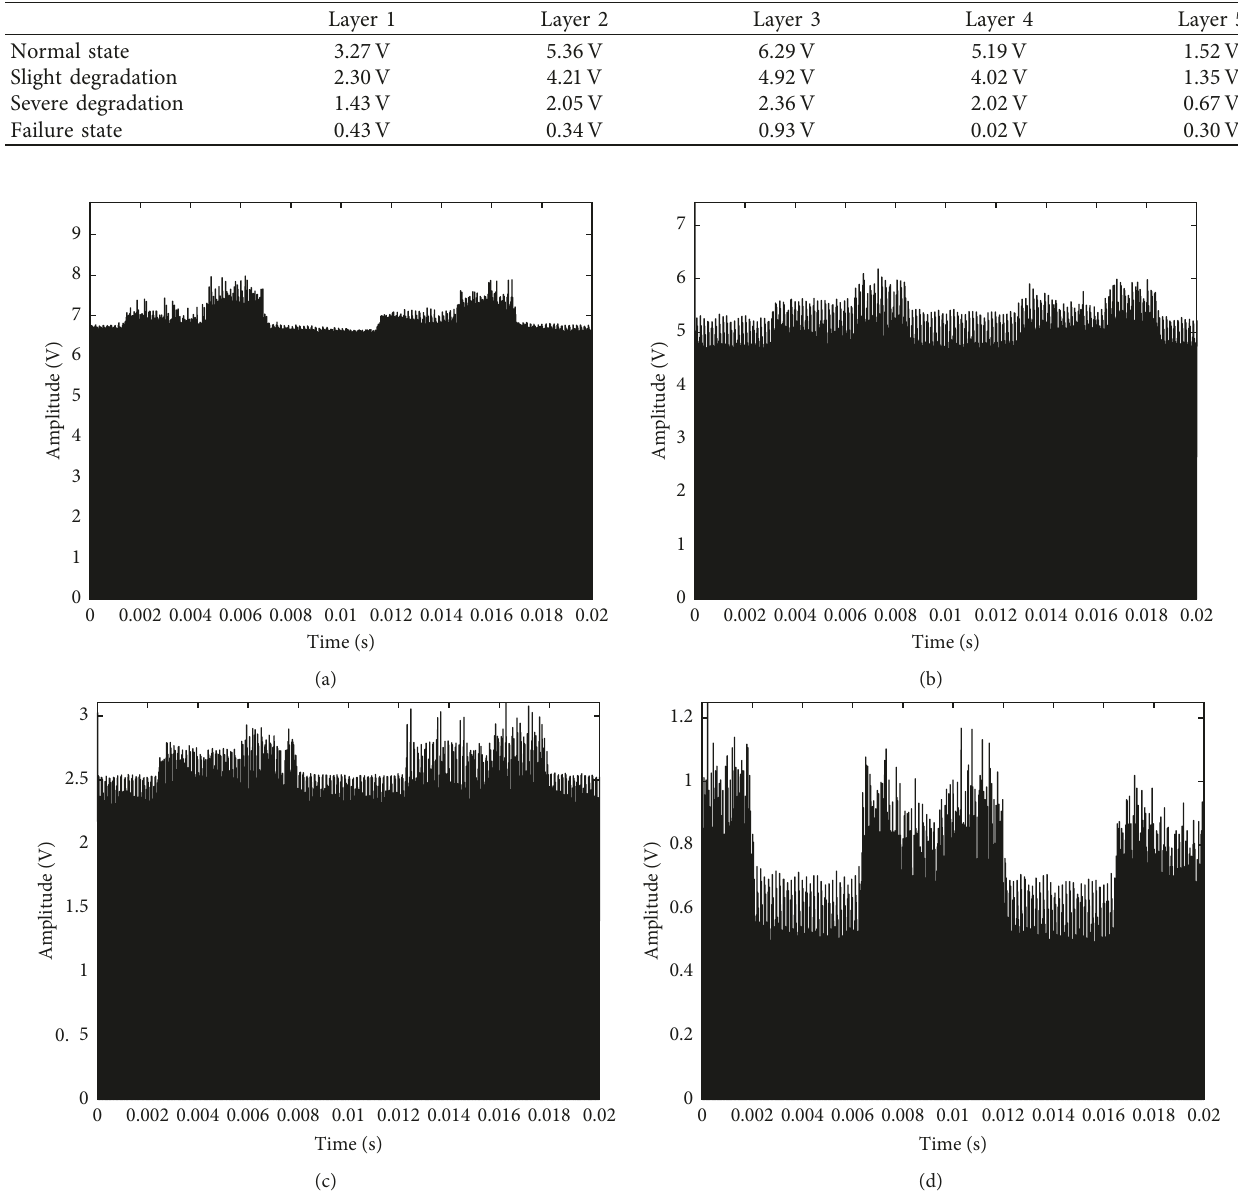
Figure 6: The waveform of the reconstructed signal: (a) normal state; (b) slight degradation; (c) severe degradation; (d) failure